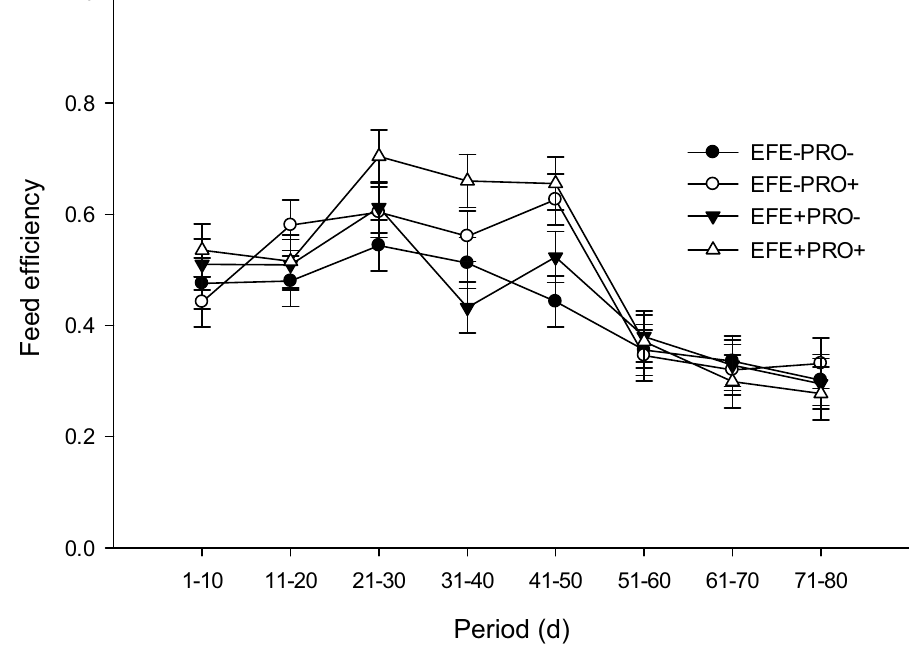
Figure 3. Feed efficiency in calves receiving different experimental diets. Treatments were (1) calves fed diets without exogenous fibrolytic enzymes (EFE)-treated wheat straw and probiotic supplement (EFE-Pro−), (2) calves fed diets of EFE-treated wheat straw but with probiotic supplement (2 g/d/calf; EFE-Pro+), (3) calves fed EFE-treated wheat straw (2 g/d/calf) but without probiotic supplement (EFE+ Pro−), (4) calves fed EFE-treated wheat straw and probiotic supplement (EFE+ Pro+). Exogenous fibrolytic enzymes were applied to wheat straw. Data are presented as means ±